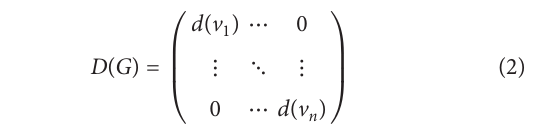
in Figure 5 . The starting point of convolution on a topological graph is similar to that of image convolution. The basic idea is to generate a new feature graph by integrating the features of the points adjacent to the central point and parameterize the